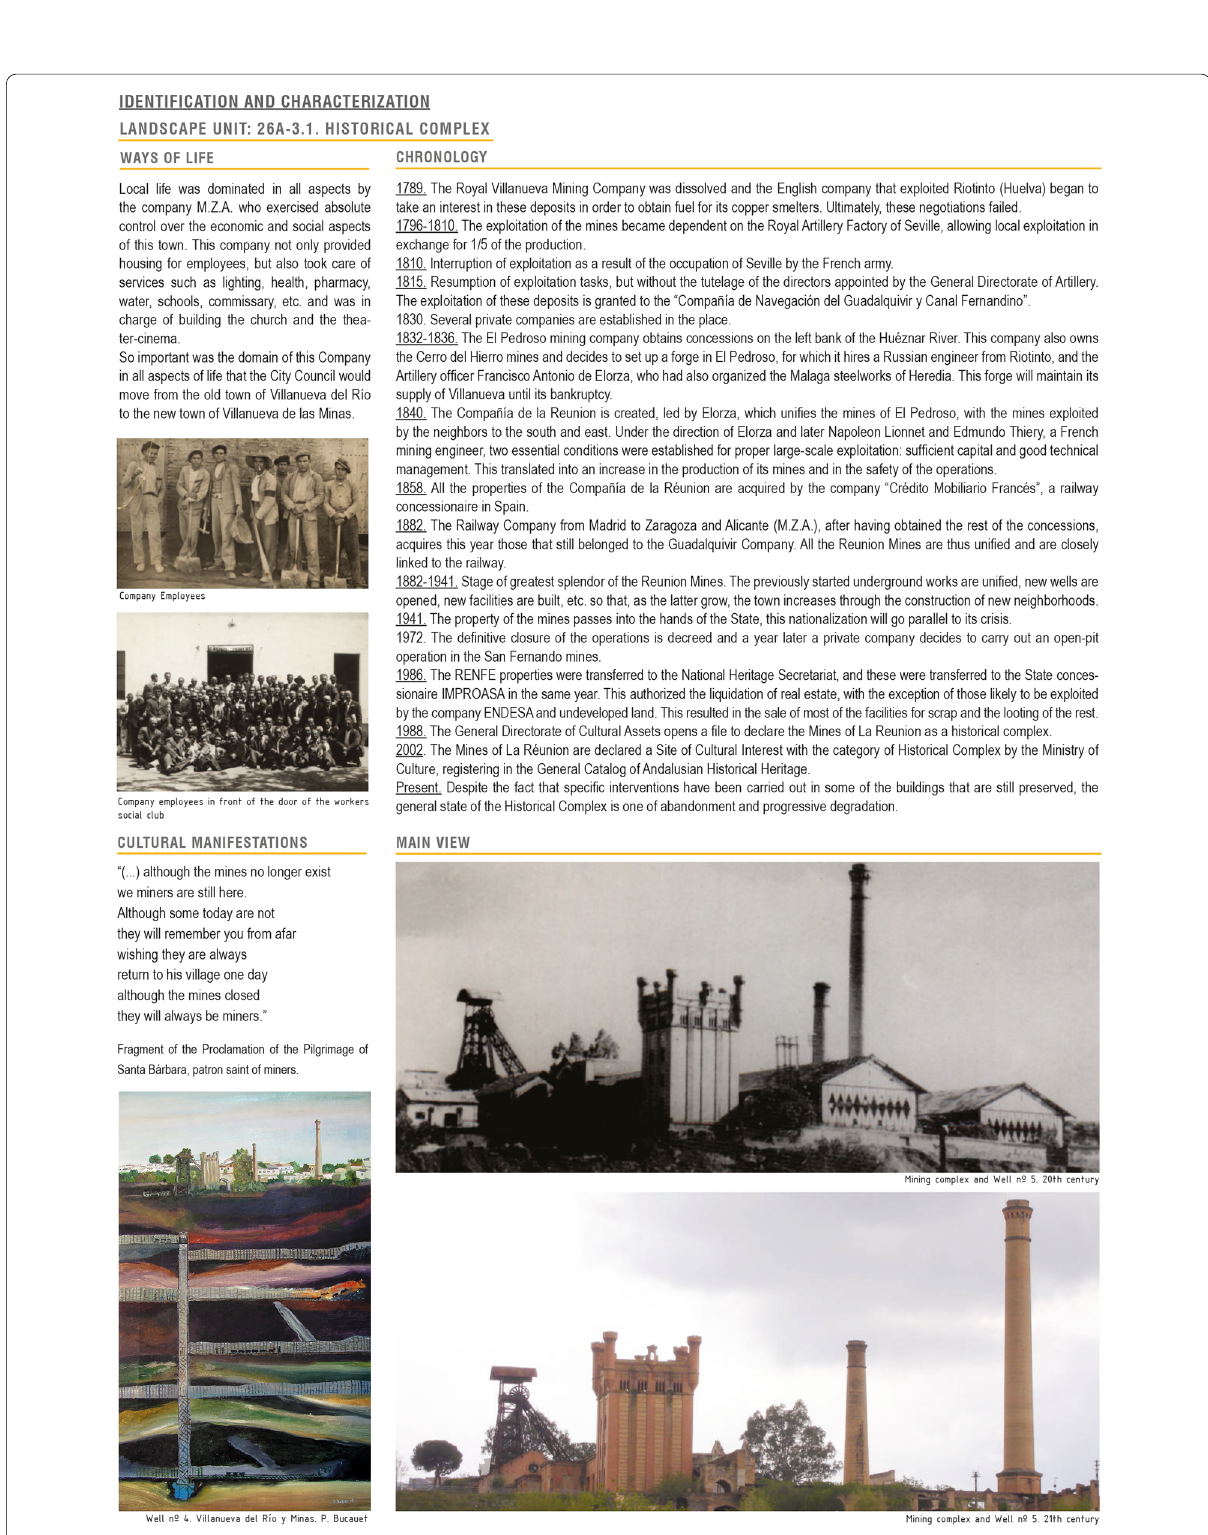
Fig. 7 Identification and characterization of a landscape unit. Source: Own